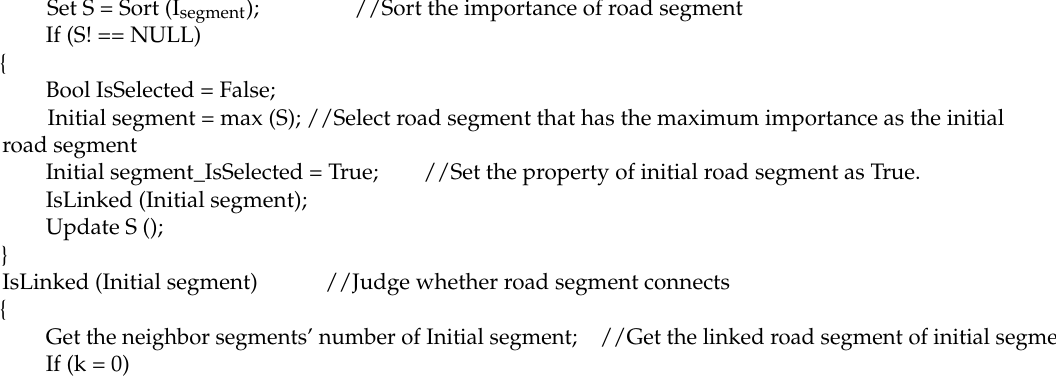
Table 1. Pseudo-code for the stroke generation